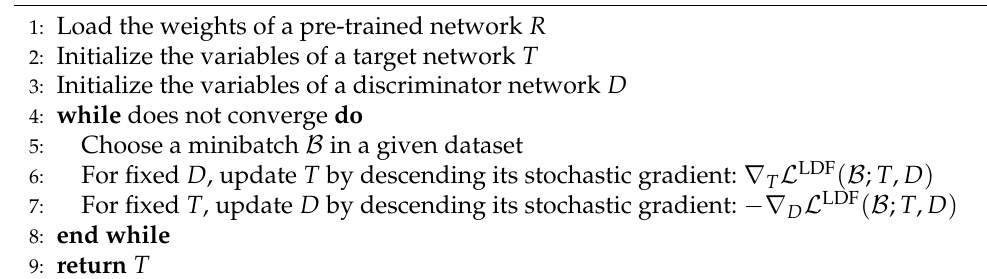
Algorithm 1 Adversarial-based knowledge transfer procedure with